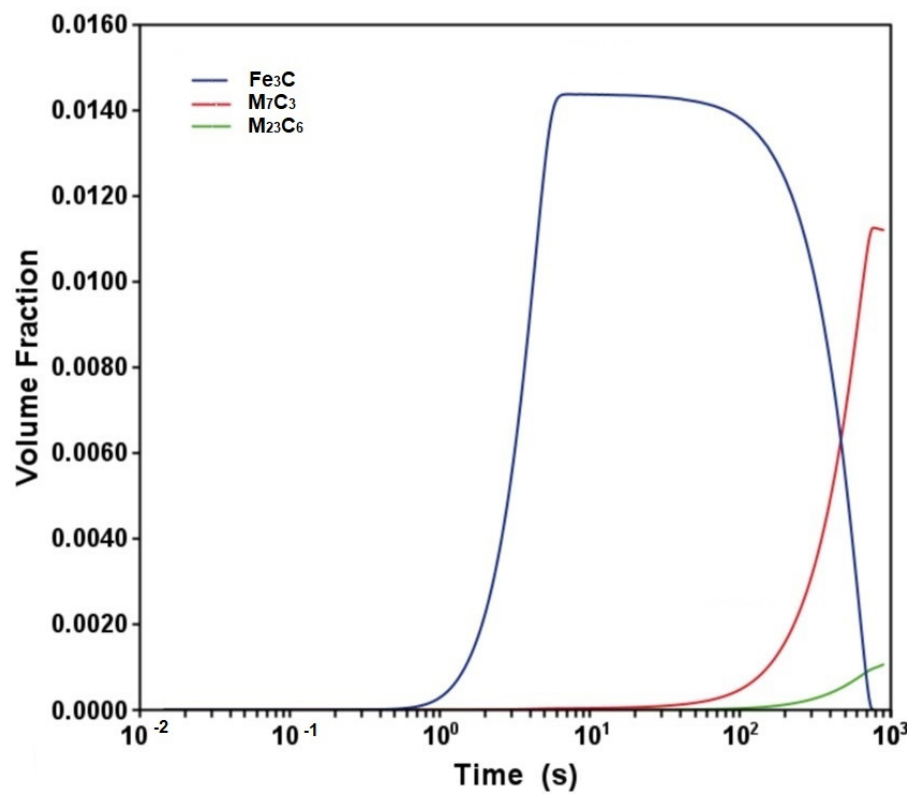
Figure 9. Calphad-calculated volume fraction of precipitates vs. time during aging at 715 °C.